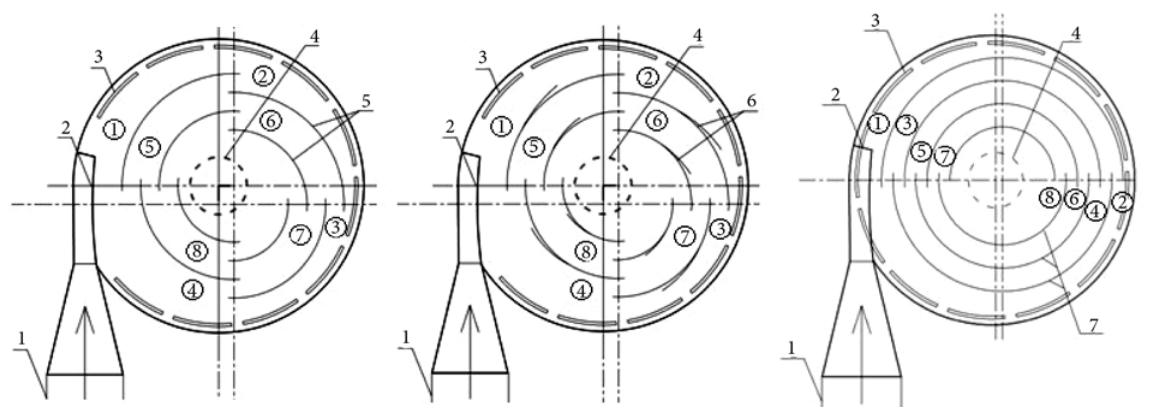
Fig. 2. Diagram of the internal structure of one-level 8-channel cyclone: 1 – polluted airflow supply duct, 2 – airflow inlet, 3 – segment circular slits, 4 – cleaned airflow outlet, 5 – curvilinear quarter-rings of different radius, 6 – opened plates, 7 – curvilinear semi-rings; 1–8 – sequential number of the channel